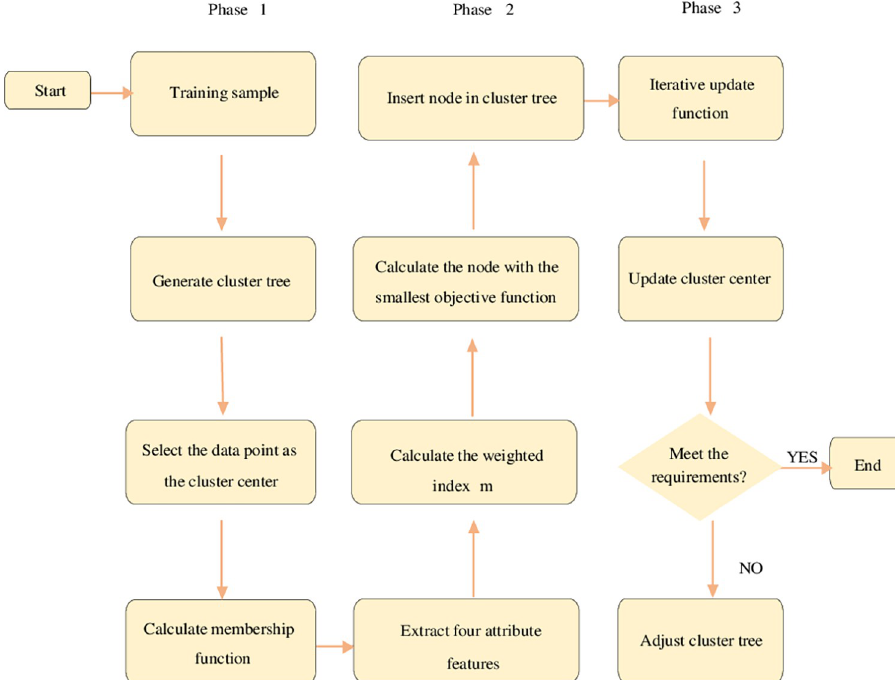
Fig 3. Workflow of NAD model based on FCM clustering